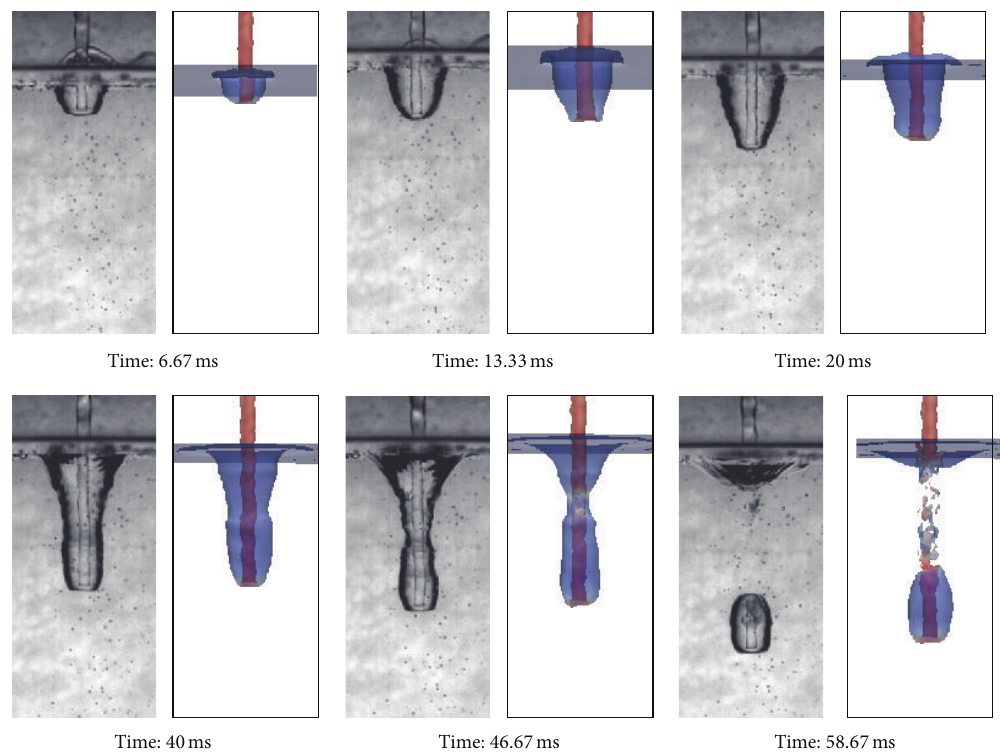
Figure 3: Side-by-side comparison of the experiments of Qu et al. [13] with the present simulation on the refined mesh.